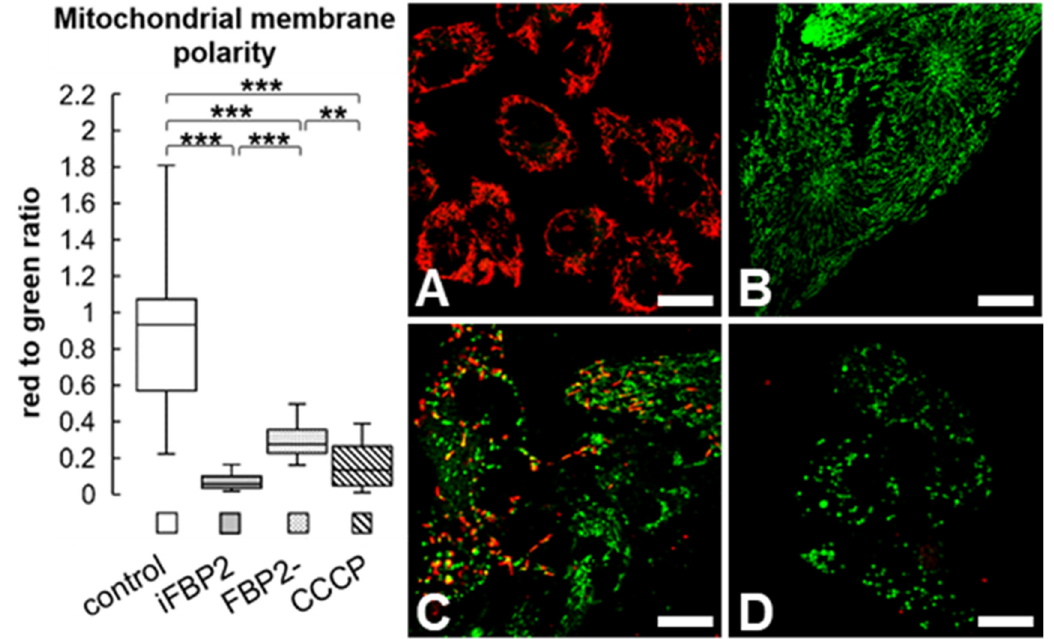
Figure 2. Mitochondrial membrane polarity in HL-1 cells. Representative microscopic images of cells stained with JC-1, and quantification of red to green fluorescence intensity in the cells. The fluorescence was normalized to control group. Data are presented as median and interquartile range. Control—untreated HL-1 WT cells ( A ), iFBP2—FBP2 tetramerizing agent-treated cells ( B ); FBP2—-cells with partially silenced expression of FBP2 ( C ), CCCP—HL-1 WT cells incubated with CCCP ( D ), a mitochondria depolarizing agent. ** p < 0.01 *** p < 0.001. Bar = 20 µm.